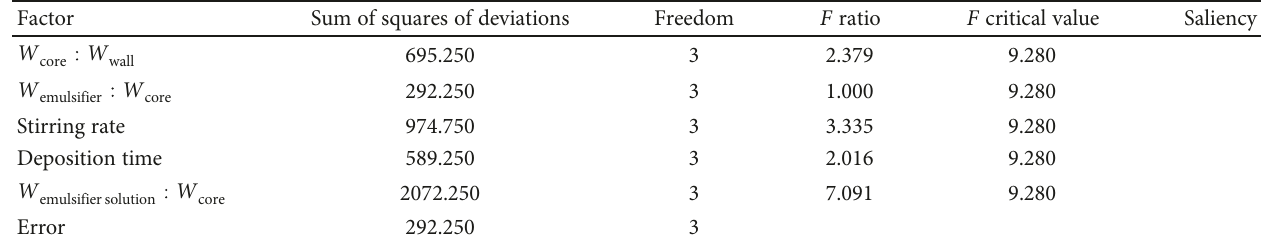
Table 9: Remarkable analysis of coverage rates of